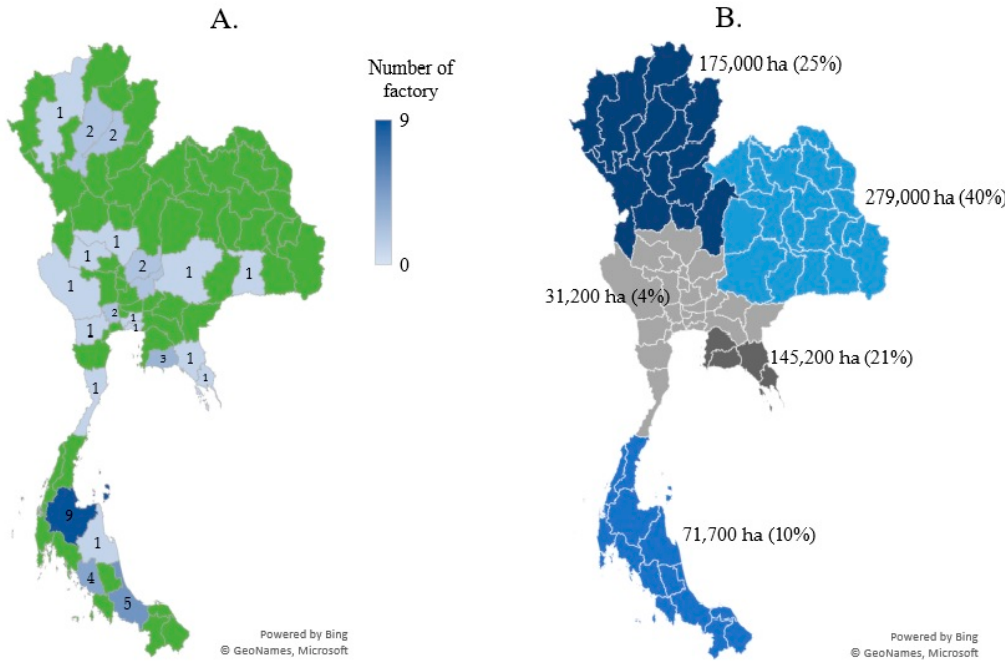
Figure 4. Comparing number of wood pellet factories and wasteland by region in Thailand. ( A ) Number of wood pellet factories [35], ( B ) Wasteland by region [36]. Table 10. Comparison of Cases 1 and 2 in terms of job opportunity, GHG emissions and increase in cost.